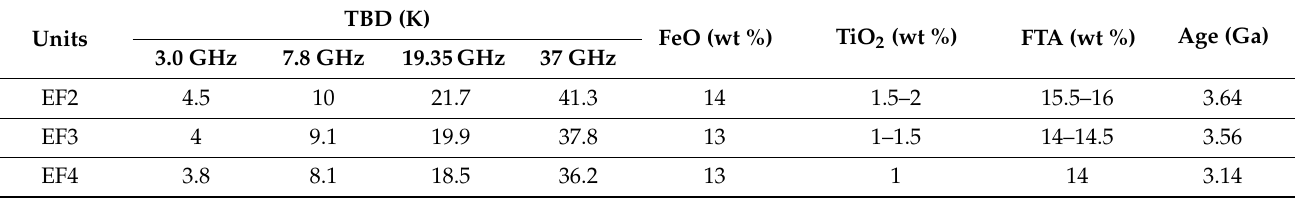
Table 4. The SCREP-based FeO, TiO 2 , and FTA values mapped by Kramer et al. [2] and the four- channel TBDs of the EF2, EF3, and EF4